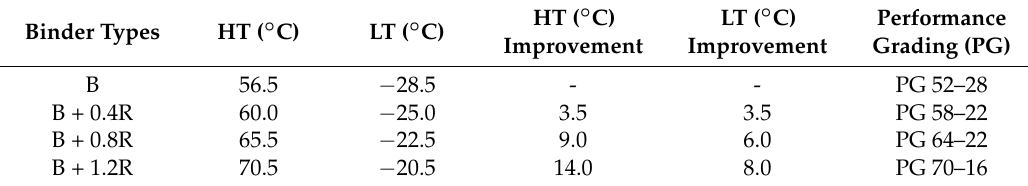
Table 8. The effects of Elvaloy ® RET on performance grading of B 160/220